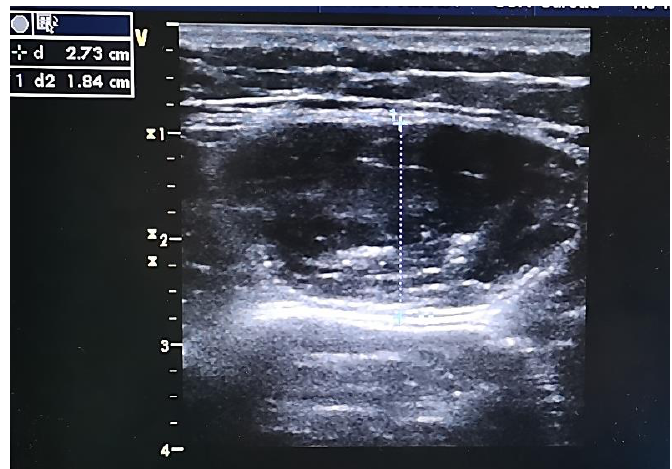
Figure 2. Ultrasonography picture of the RF.